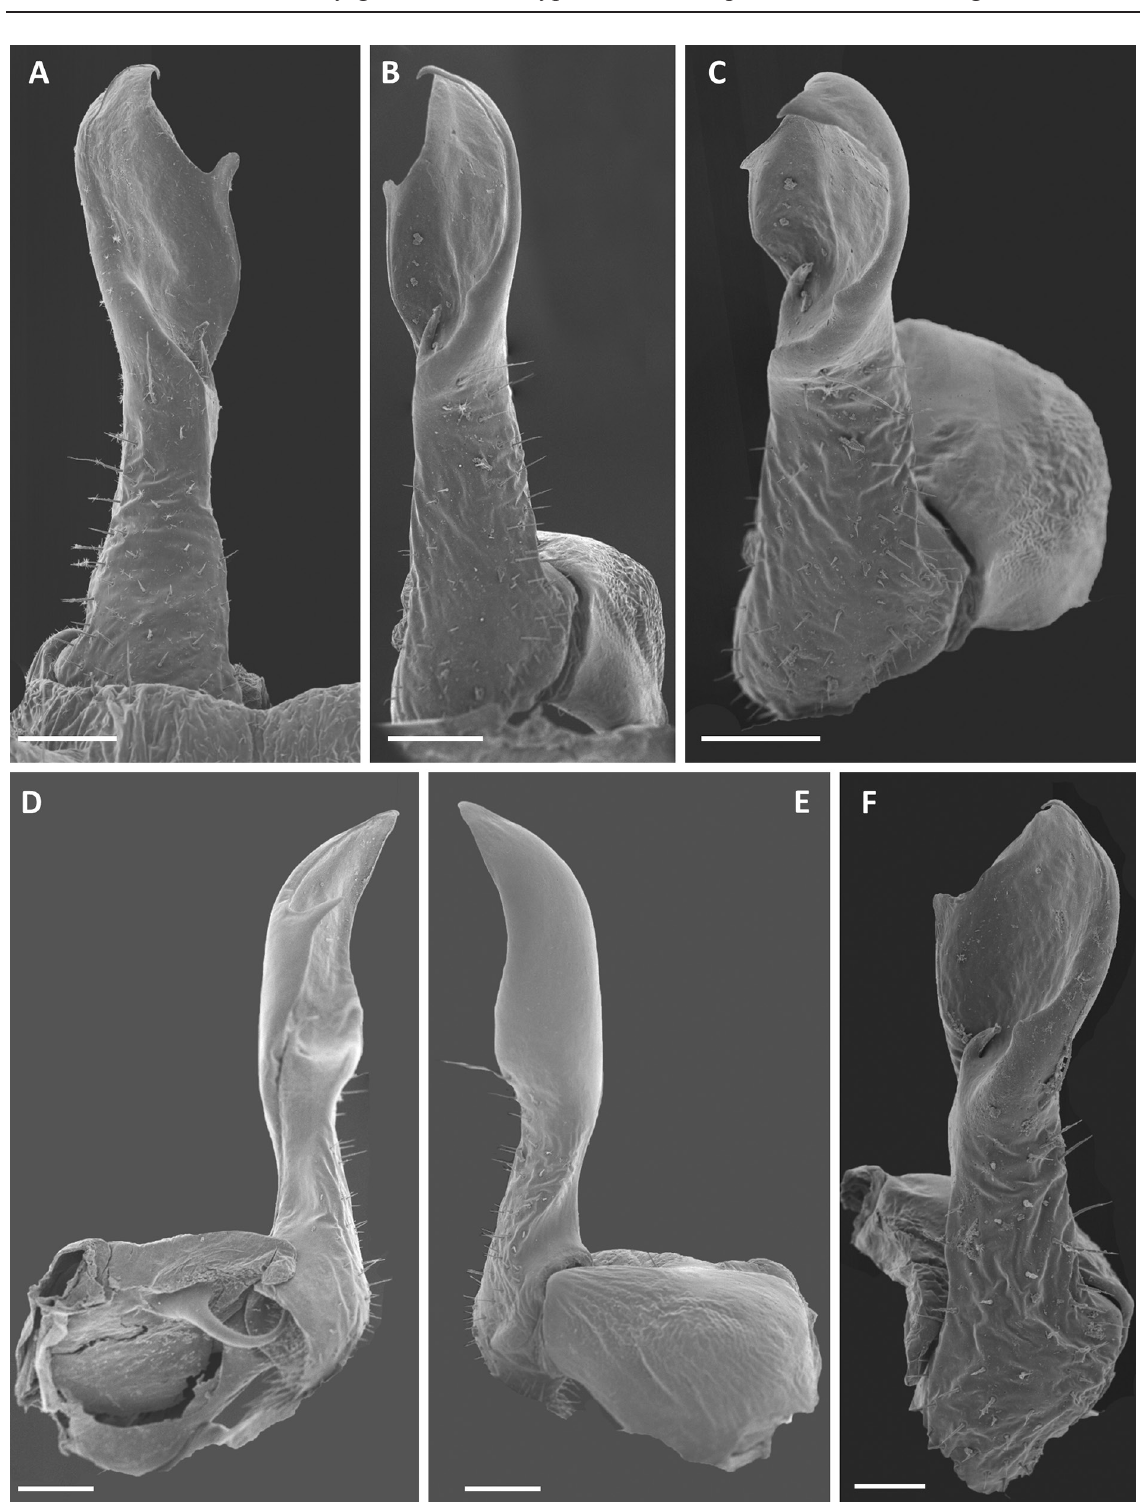
Fig. 16. Elythesmus enghoffi Hoffman, 1978, gonopods. A . Topotype, ♂, with 18 podous rings from Amani, East Usambara Mts (NHMD 621816), right gonopod, ventral view. B–E . ♂ (NHMD 621778) with 17 podous rings from Kidatu, left gonopod. B . Ventral view. C . Oblique (slightly apical) meso- ventral view. D . Mesal view. E . Lateral view. F . Specimen (NHMD 621787) with 18 podous rings from Kidatu, right gonopod, meso-ventral view. Scale bars: A–E = 0.1 mm; F = 0.05